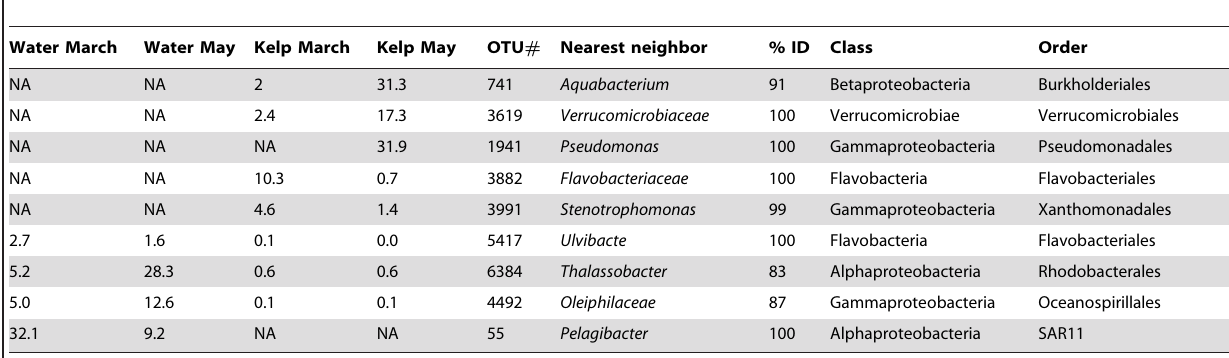
Table 2. Most dominant OTUs in all sites sampled for this study and their average relative abundances (as percentages of all sample 16S rRNA gene sequences